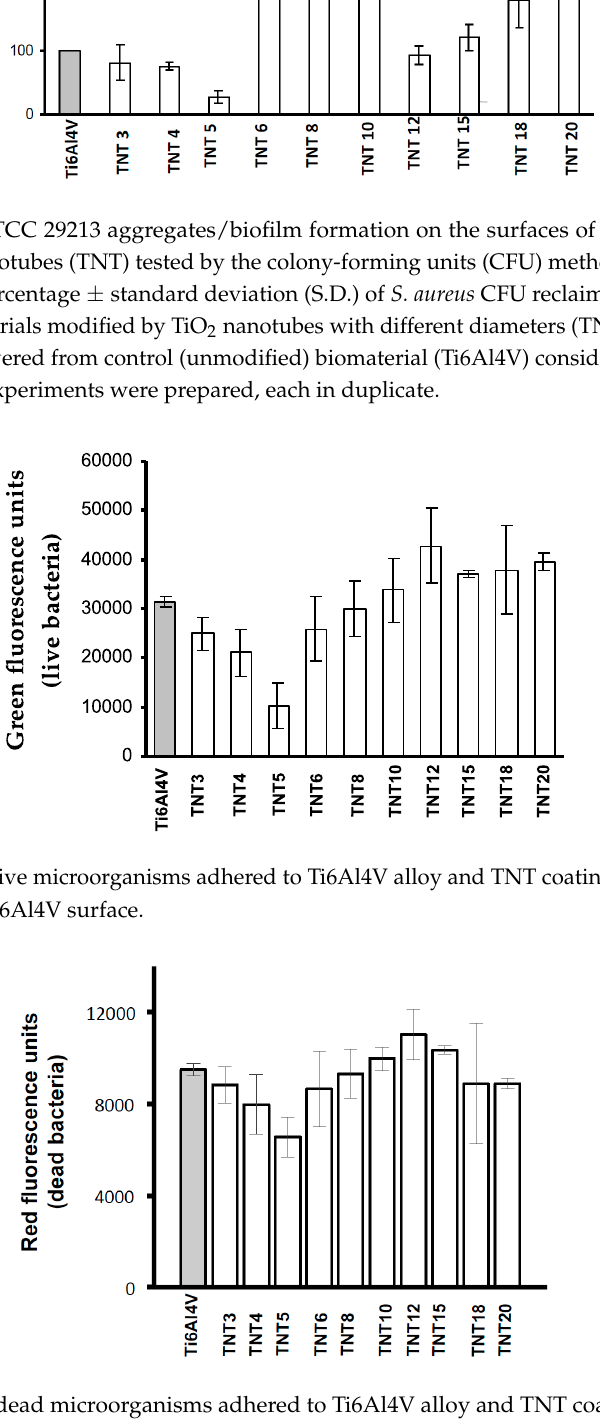
Figure 8. Number of dead microorganisms adhered to Ti6Al4V alloy and TNT coatings, obtained in the anodic oxidation of Ti6Al4V surface.